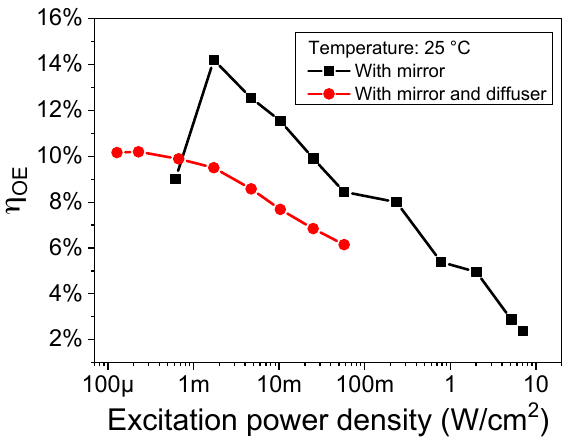
Figure 7. Variation in efficiency with a more uniform excitation over the whole receiver area.